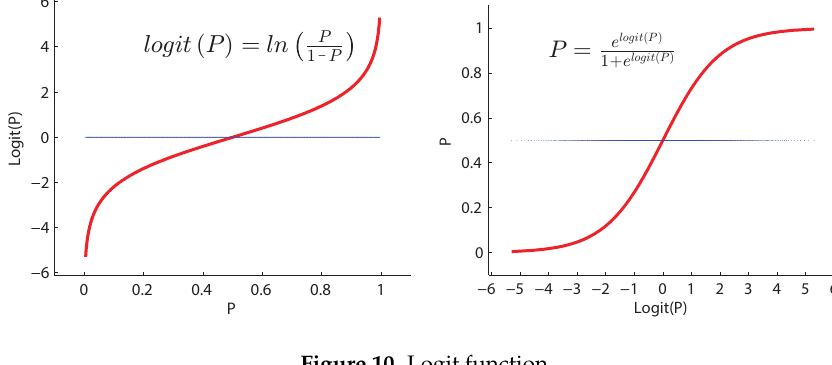
Figure 10. Logit function.